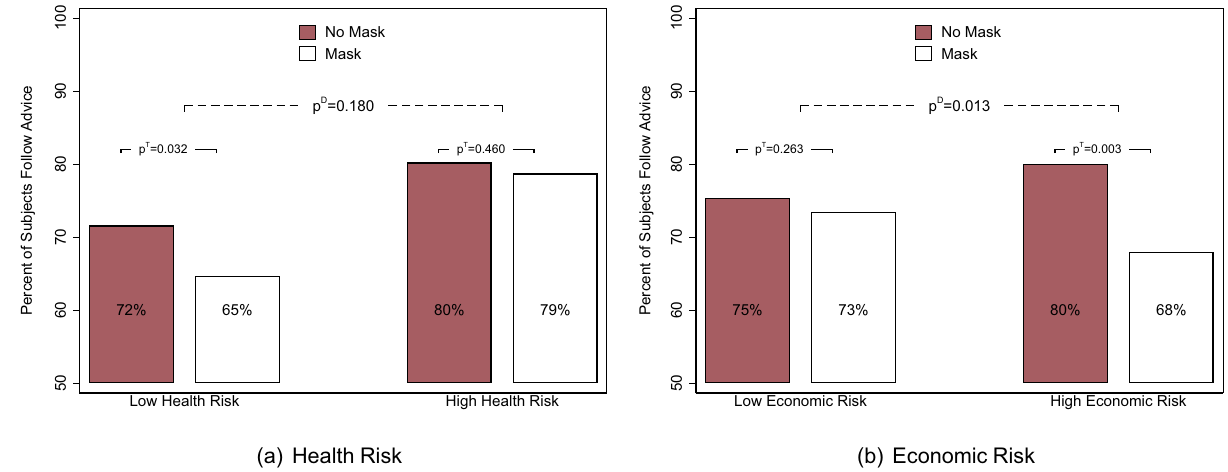
Figure 3. Following advice by risk. Notes : The bars in red depict the unconditional mean in the control (no mask) condition ( N = 906 ), and the bar in white depicts the mean in the treatment (mask) condition ( N = 961 ). The p T -value represents the p -value for the treatment effect, and the p D -value is the p -value for the difference across the treatment effects for the mentioned groups on the x-axis. Standard errors are clustered at the state level. Conditional estimates controlling for state fixed effects, week fixed effects, design controls, and individual groups are presented in Table